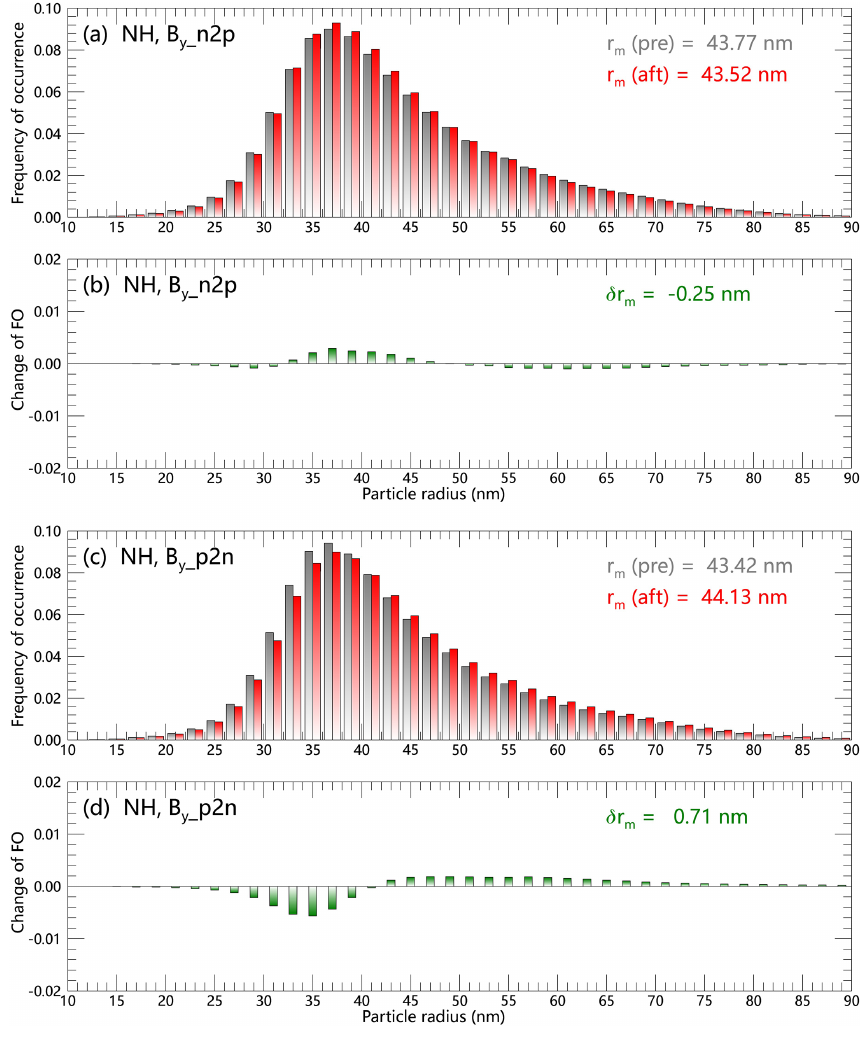
Figure 8. Similar to Fig. 7, but for the results of the Northern